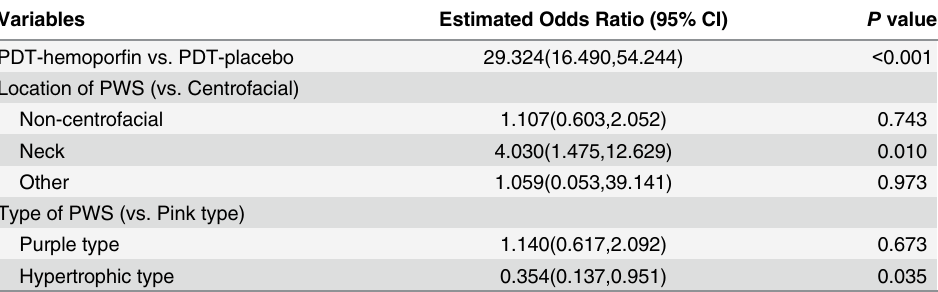
Other Type of PWS (vs. Pink type) Purple type